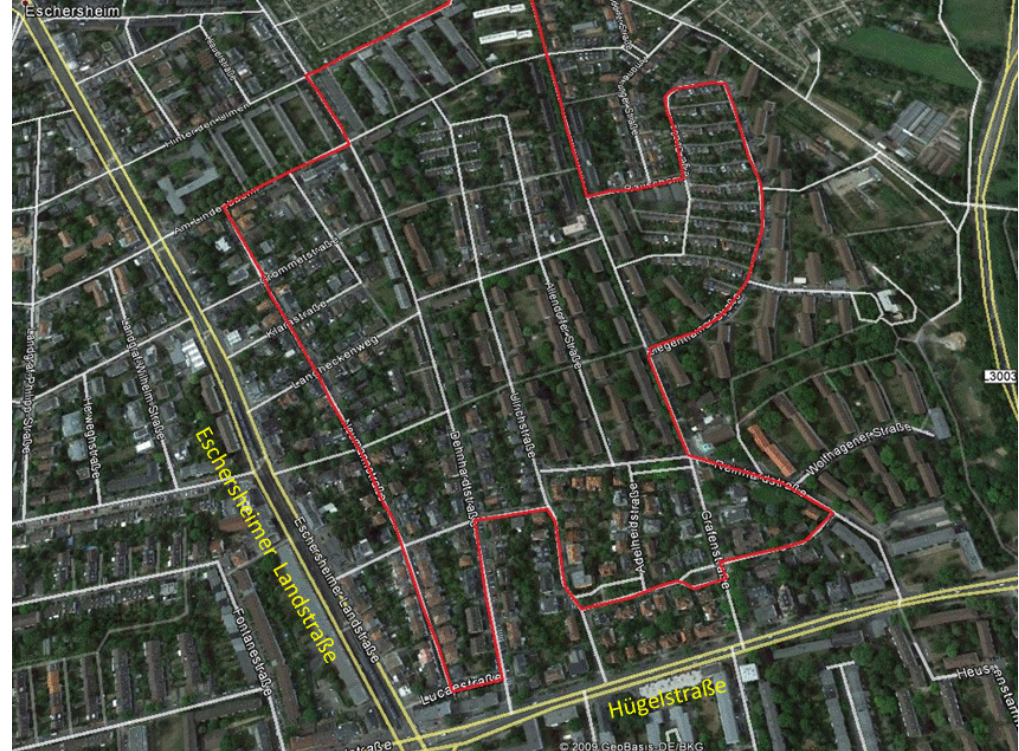
Figure 3. Course 2: Circular drive through a residential area in Frankfurkt-Eschersheim. Red line: Driving route, yellow line: Main roads. Geographical picture by Google Earth.